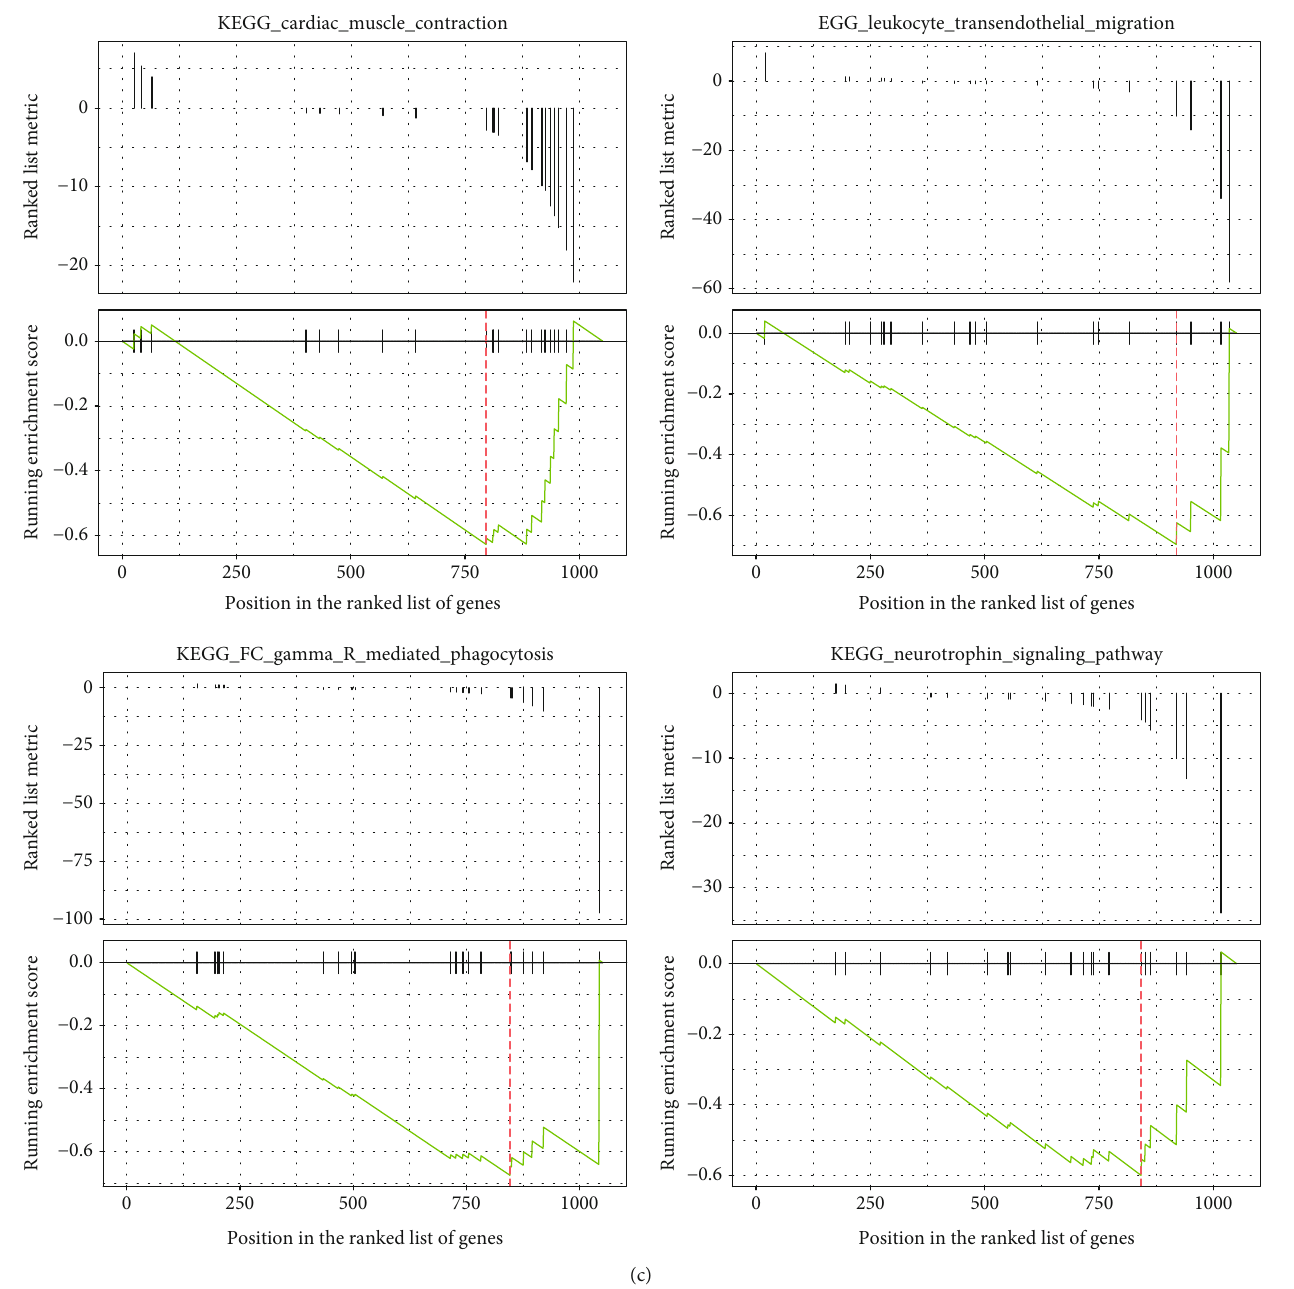
Figure 4: Gene enrichment analysis of the DEGs in both the healthy and rejection kidney. (a) Volcano plot showed the statistical signi fi cance ( P value) versus the magnitude of change (fold change) of the DEGs in cluster 6 (rejection vs. healthy). (b) Dot plot showed the enriched KEGG signaling pathways of the cluster 6 marker genes between the rejection and healthy samples. (c) GSEA analysis identi fi ed the upregulated or downregulated DEGs in the indicated signaling pathway (rejection vs.